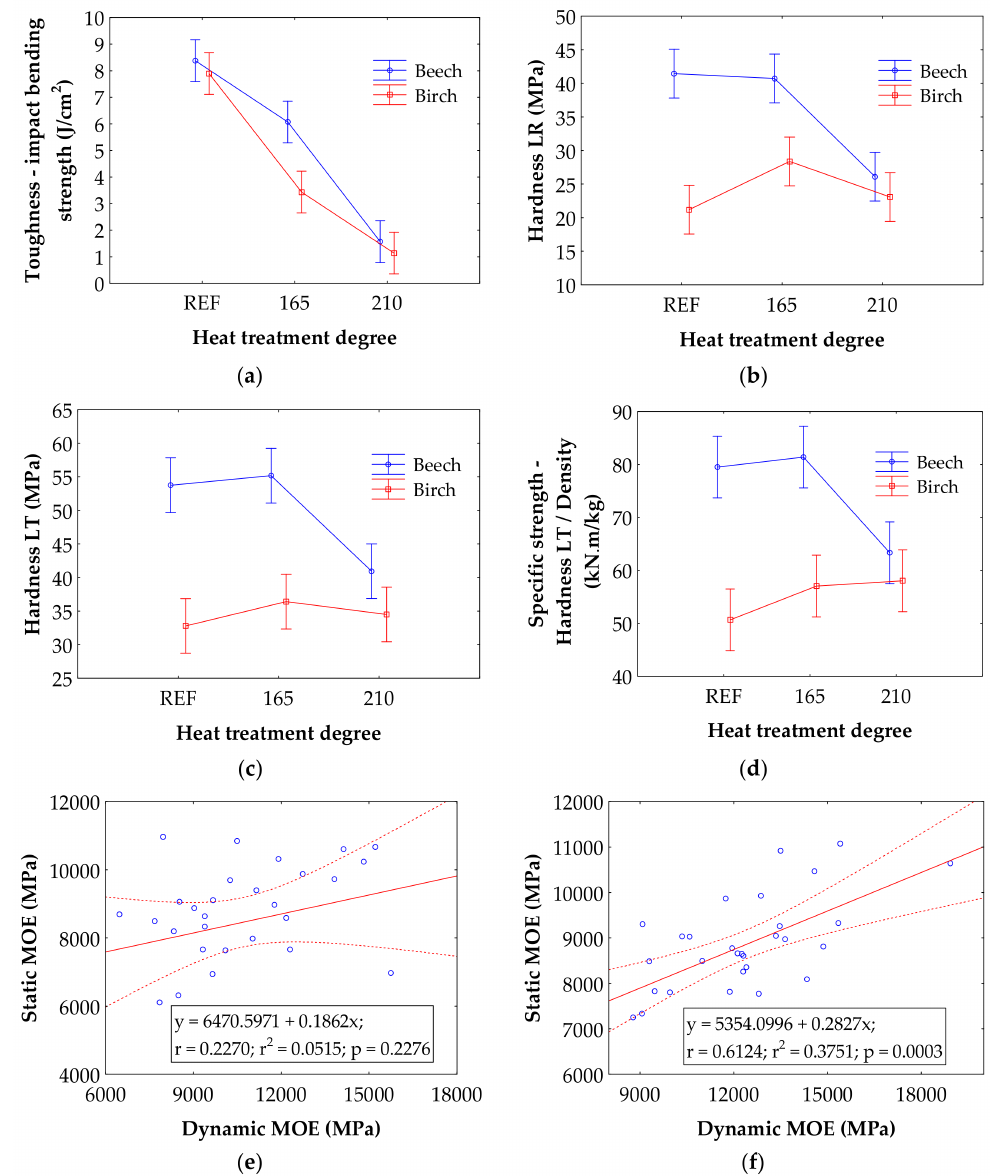
Figure 6. Graphic visualization of the effect of wood species and heat treatment temperature on ( a ) impact bending strength; ( b ) hardness LR; ( c ) hardness LT; ( d ) specific strength for hardness LT, at a 95% significance level. The relationship between static and dynamic elasticity moduli is shown in ( e )-beech, 210 ◦ C and ( f )-birch, 165 ◦ C. MOE = Modulus of